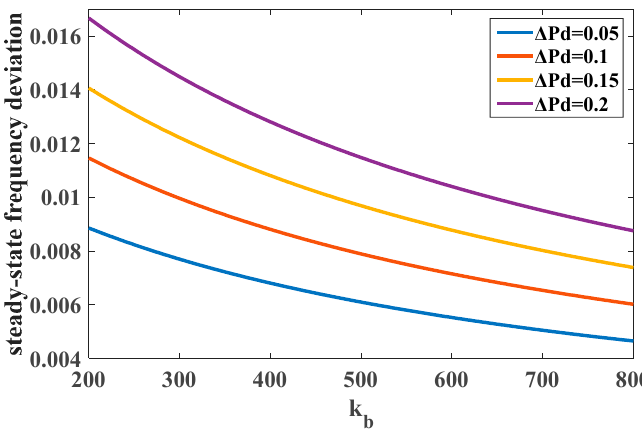
Figure 4. Curves of steady-state frequency deviation (SFD) under different parameter k b .